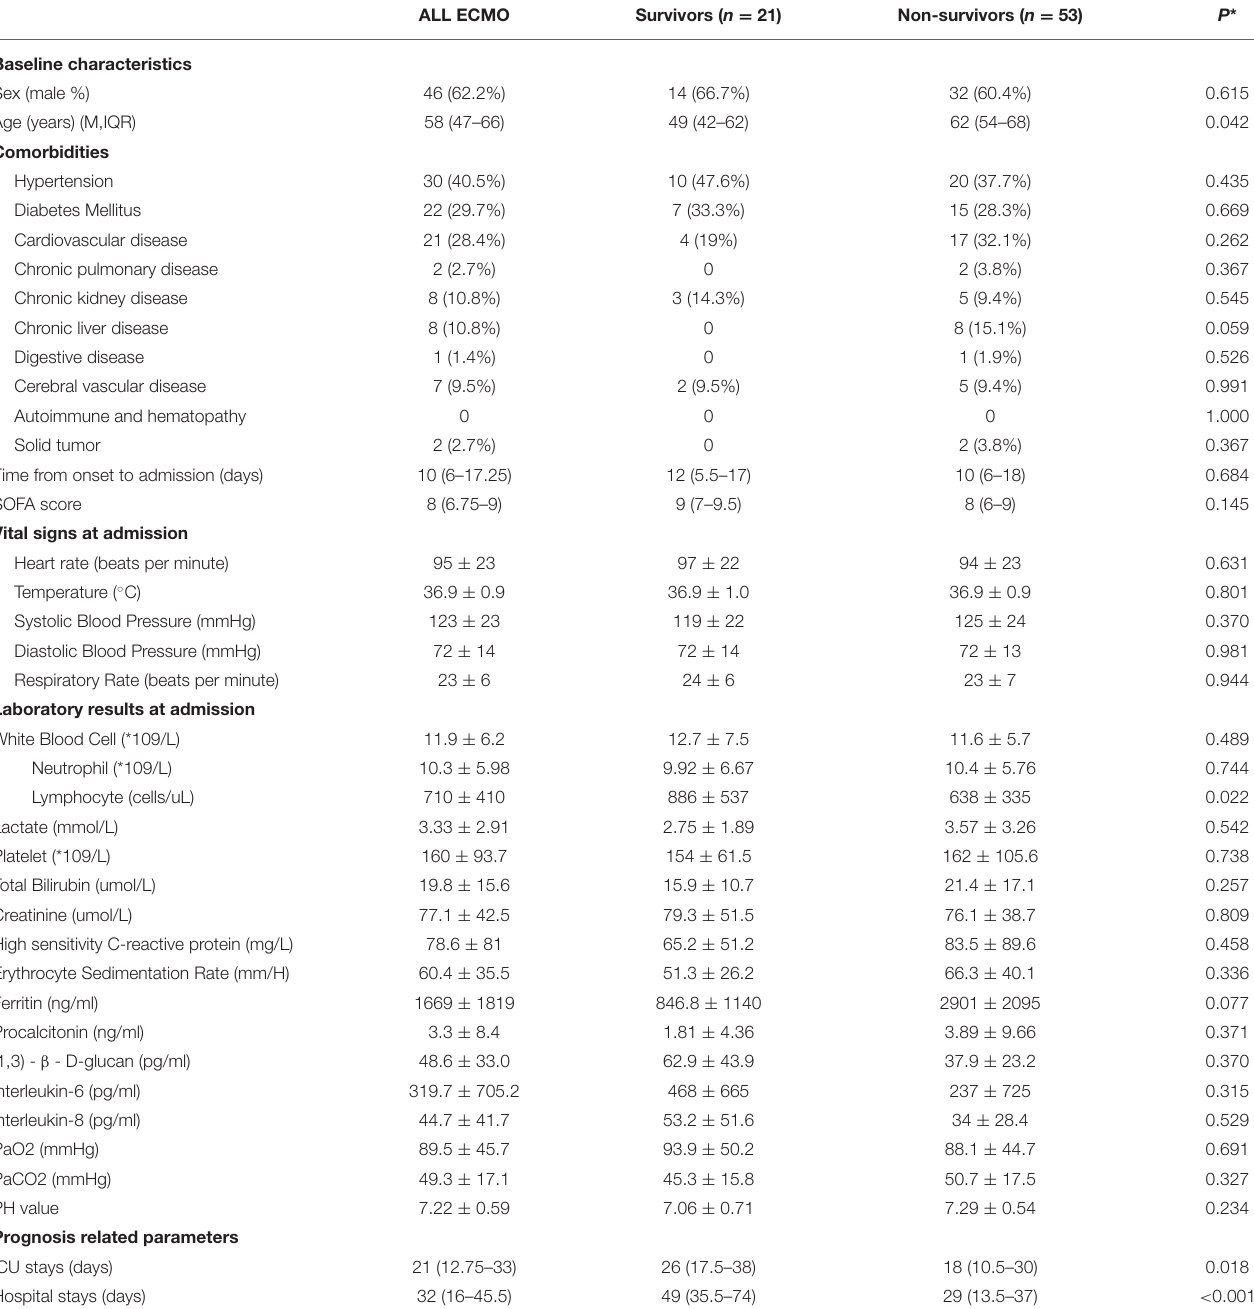
TABLE 2 | Clinical characters of the ECMO-supported patients. ALL ECMO Survivors ( n = 21) Non-survivors ( n = 53) P